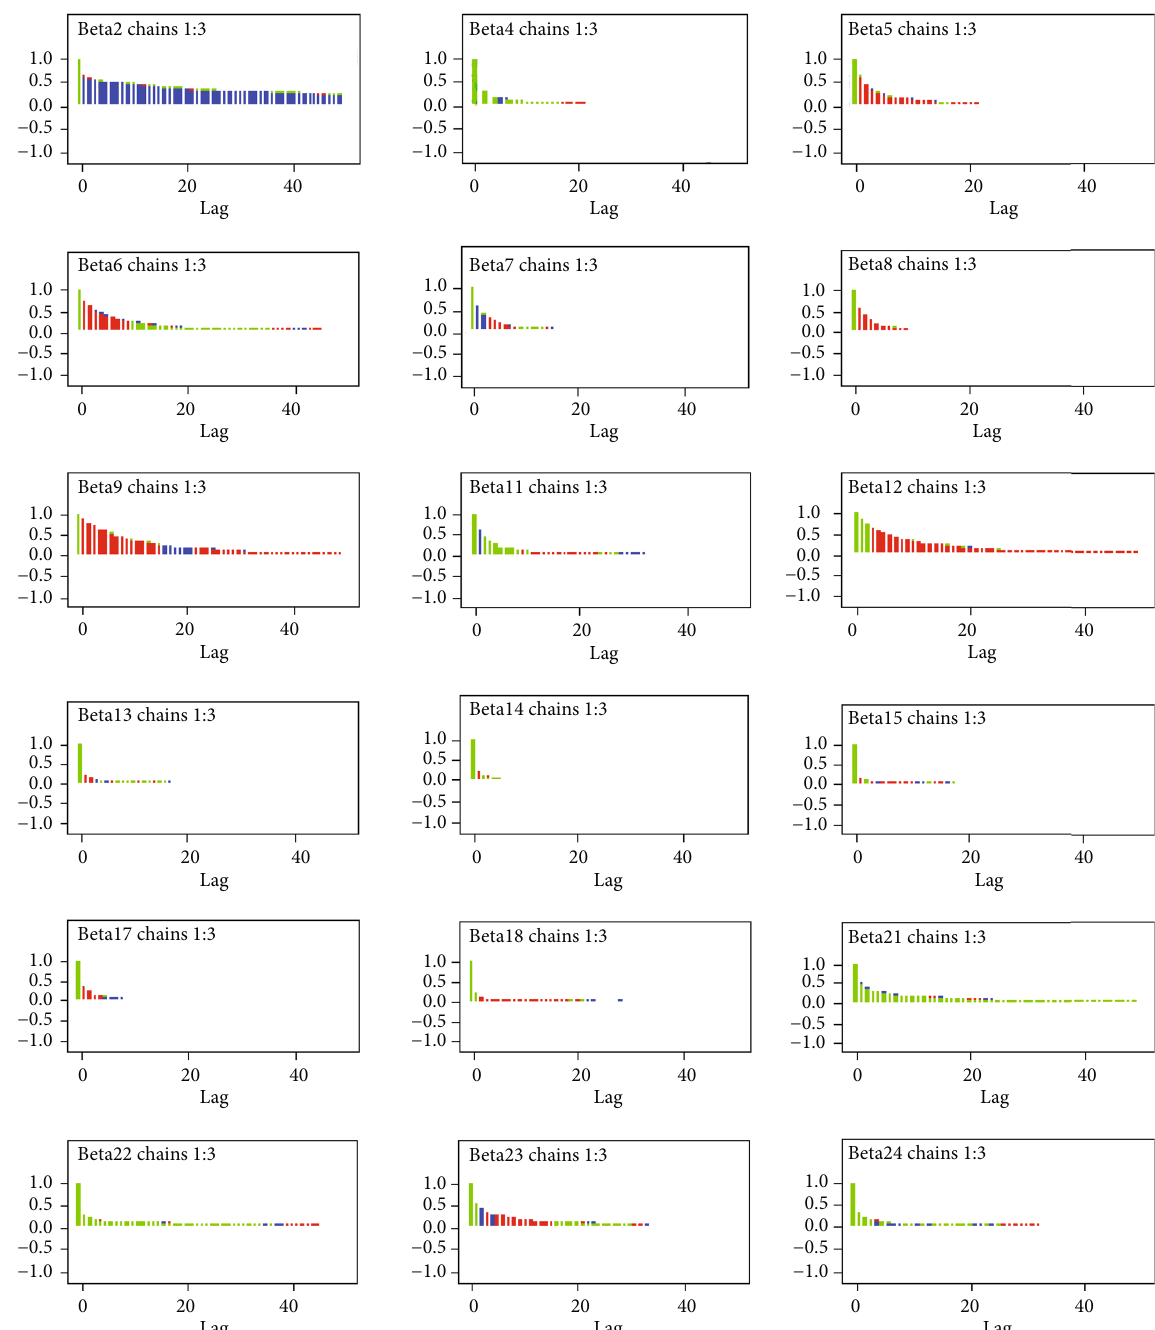
Figure 3: Autocorrelation plot for convergence of coe ffi cients for the